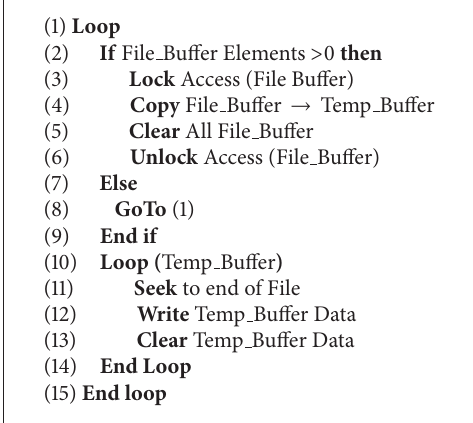
Algorithm 3: Proposed file manipulation